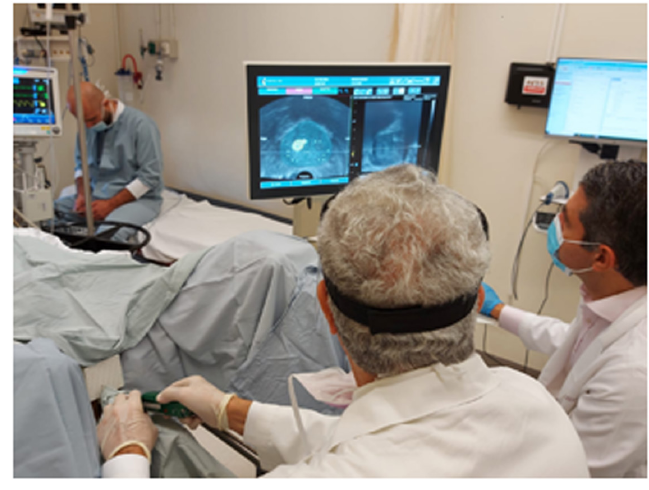
Figure 2. The transperineal biopsy set up: after contouring of the prostate and delineation of lesions on the grid, the urologist and uroradiologist take targeted and random core which are tracked live on display.